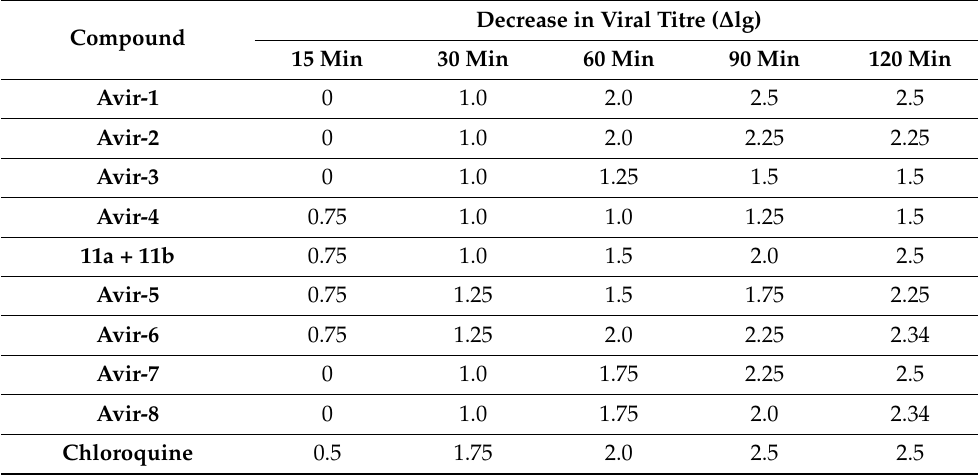
Table 7. Effect of heterocyclic compounds on the adsorption of coronavirus strain OC-43 on sensitive HCT